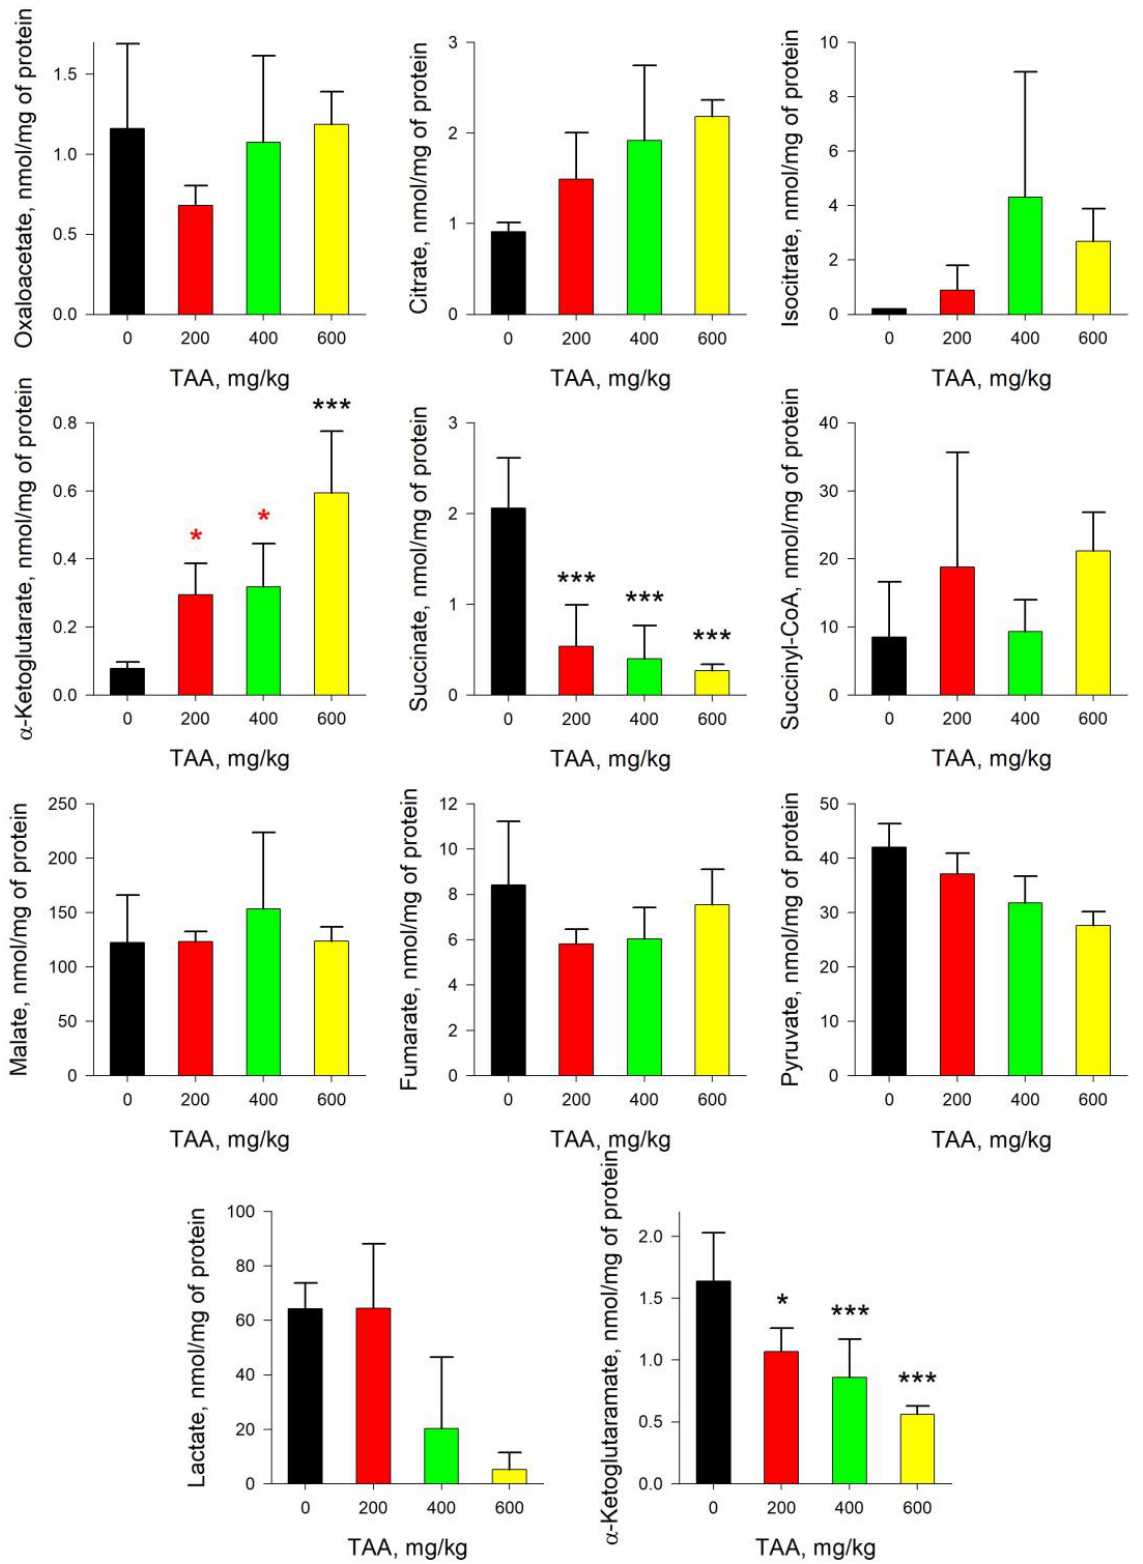
Figure 3. Concentration of TCA cycle and associated metabolites in the liver tissue of control and TAA-treated rats (AVG ± STDEV, nmol/mg of protein). p -values by Tukey ’s test: * — p < 0.1; *** — p < 0.005; black stars mean a pairwise comparison to control, red mean a pairwise comparison to TAA600 (for details see Table and Figures in Supplement S1).